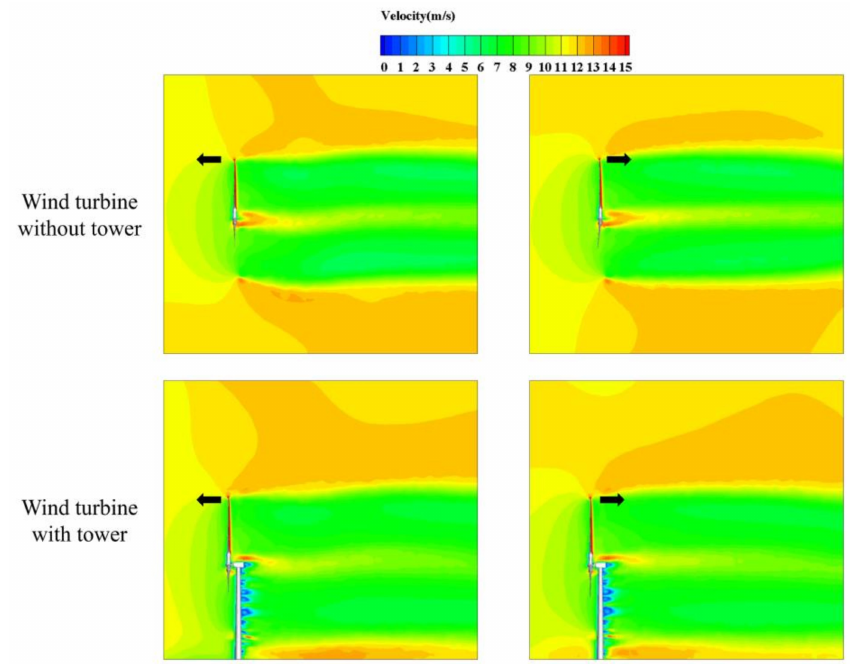
Figure 18. Velocity contours of wake field under pitch